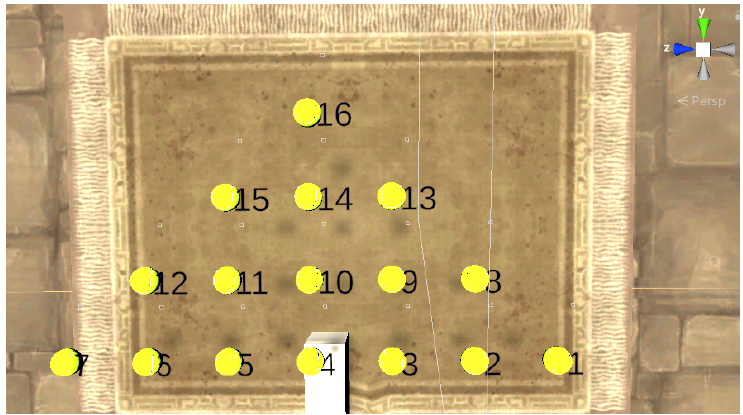
Figure 7. Virtual environment rendering of the